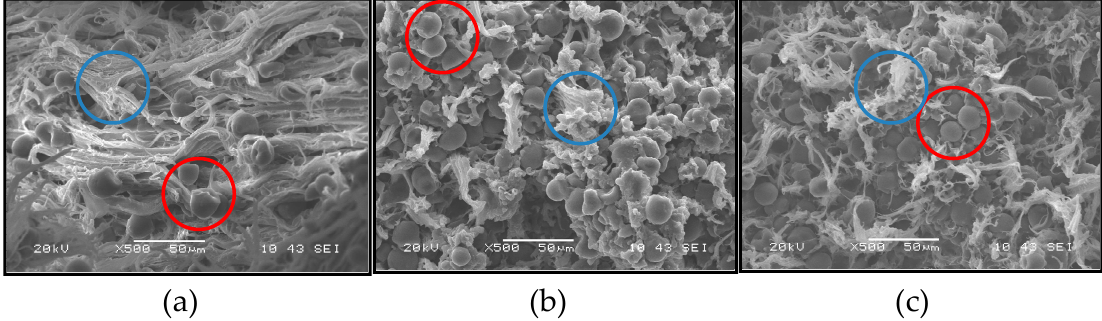
Figure 3. Scanning electron images of the fracture surface of: ( a ) TPS/PCL 40/60 binary blend; ( b ) TPS/PCL 50/50 binary blend; and ( c ) TPS/PCL 60/40 binary blend. The red circles highlight the dispersed phase constituted by the TPS and the red blue highlighted the continuous PCL.